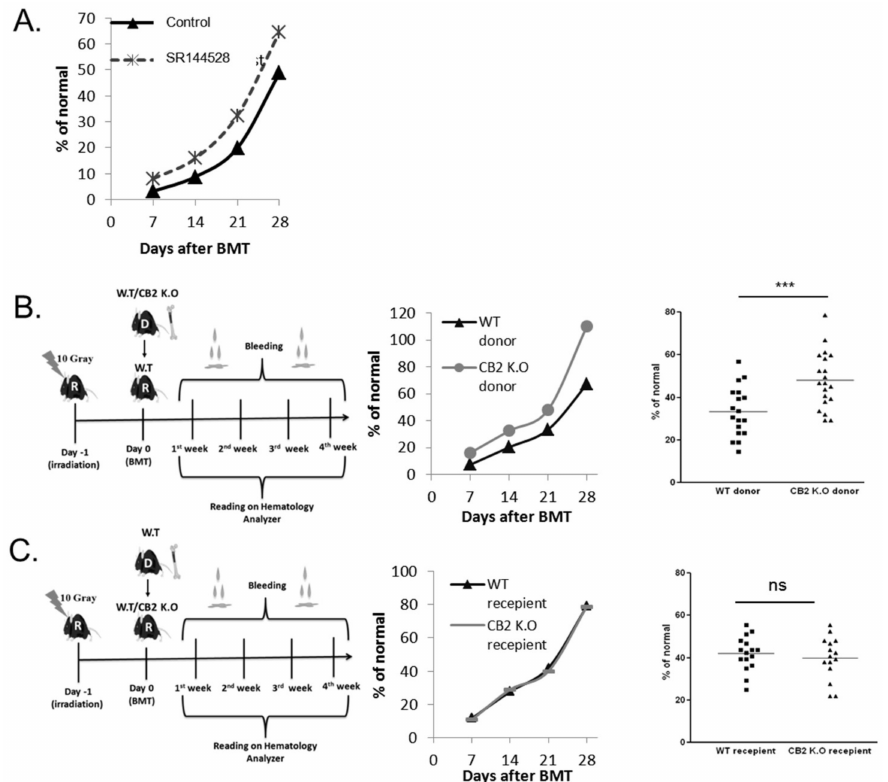
Figure 5. The role of CB2 in lymphocyte recovery. ( A ) Recipient C57BL/6 mice underwent syngeneic BMT. CB2 reverse agonist, SR144528, was administered IP once a day for 1 week from the day